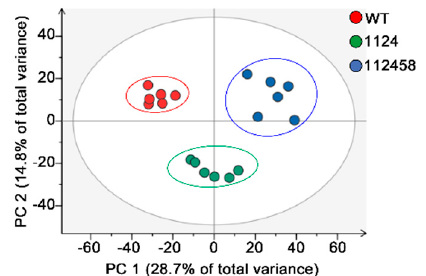
Figure 2. Principal component analysis of metabolite profiles of seedlings from wild-type (WT, red), 1124 (green), and 112458 (blue) plants. Each point represents an individual biological replicate. Plotting of the first and second component is shown. The circles indicate the 95% confidence regions.